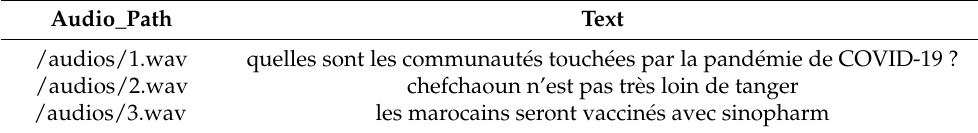
Table 1. Extract from the Test set.